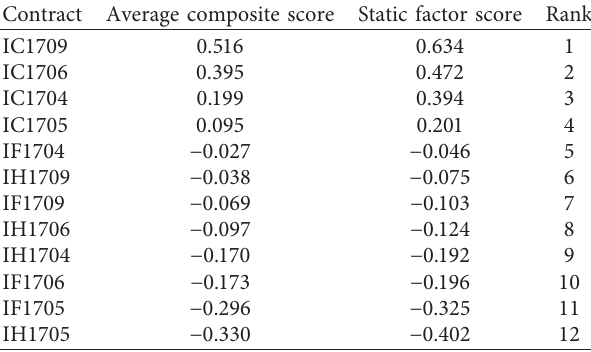
Table 15: Scores of IC, IF, and IH